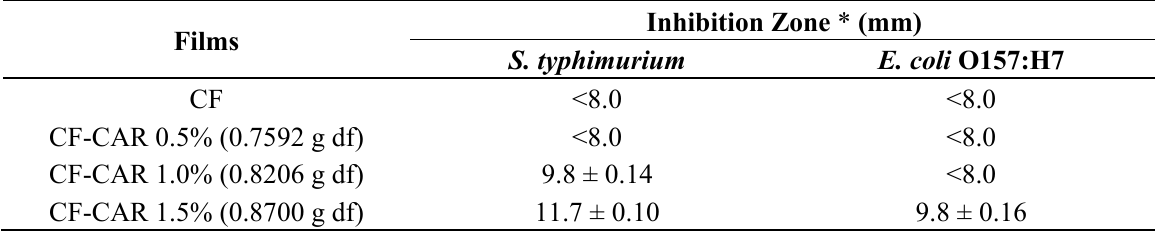
Table 4. Antibacterial activity expressed as the inhibition zone diameter (mm) of chitosan films against S. typhimurium and E. coli